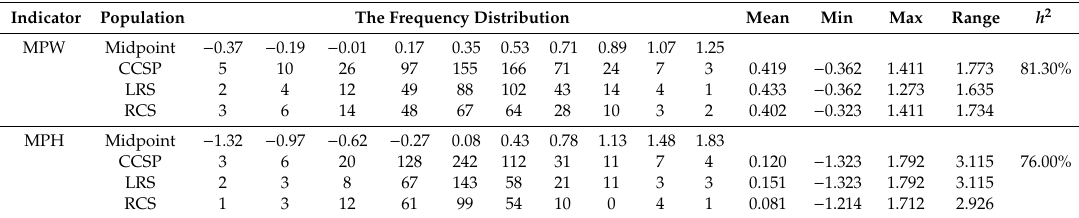
Table 1. Frequency distribution of the two drought tolerance indicators in the CCSP. Indicator